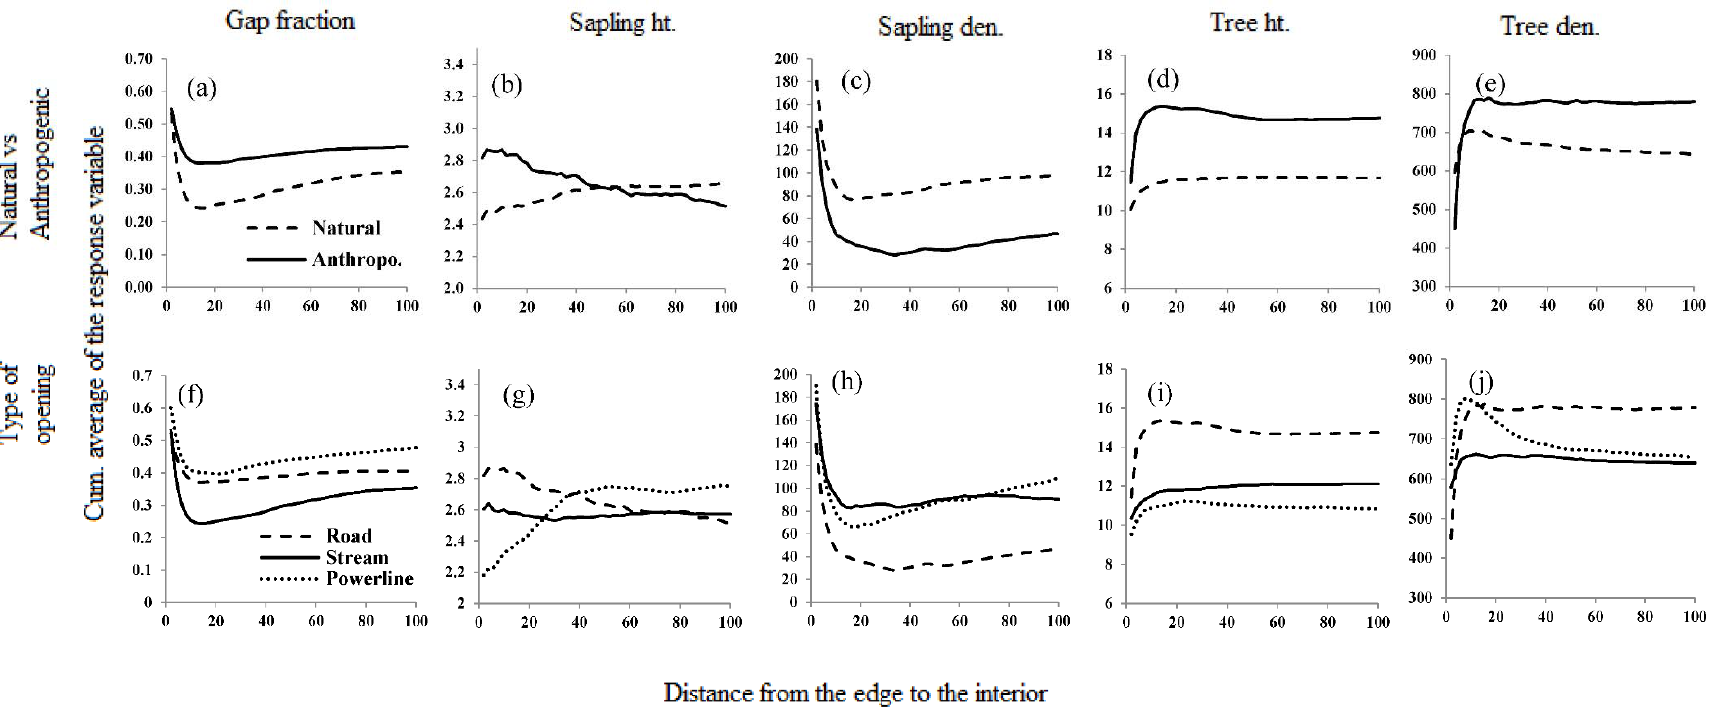
Figure 6. Depth of influence (DEI) of selected linear openings on the adjoining forest due to the natural and anthropogenic linear openings, shown by cumulative average (CUAVG) curves of response variables against the distance from the edge of a linear opening. ( a – e ) are the DEI of natural and anthropogenic openings; ( f – j ) are the DEI of the types of linear openings.